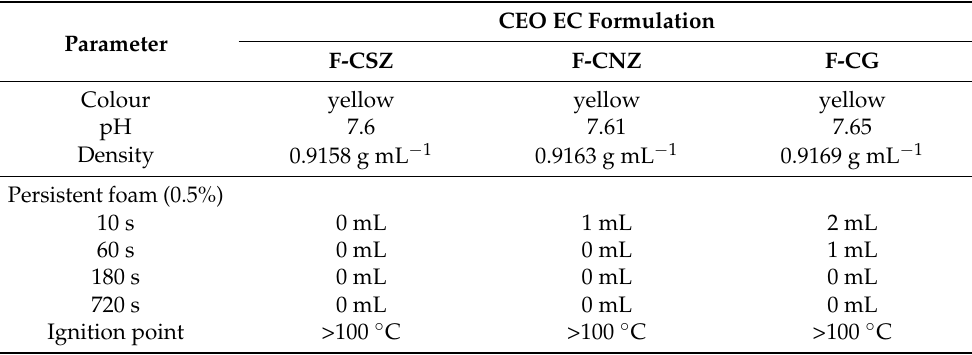
Table 3. Physical parameters of CEO EC prepared formulations in working solution (0.5%). Parameter